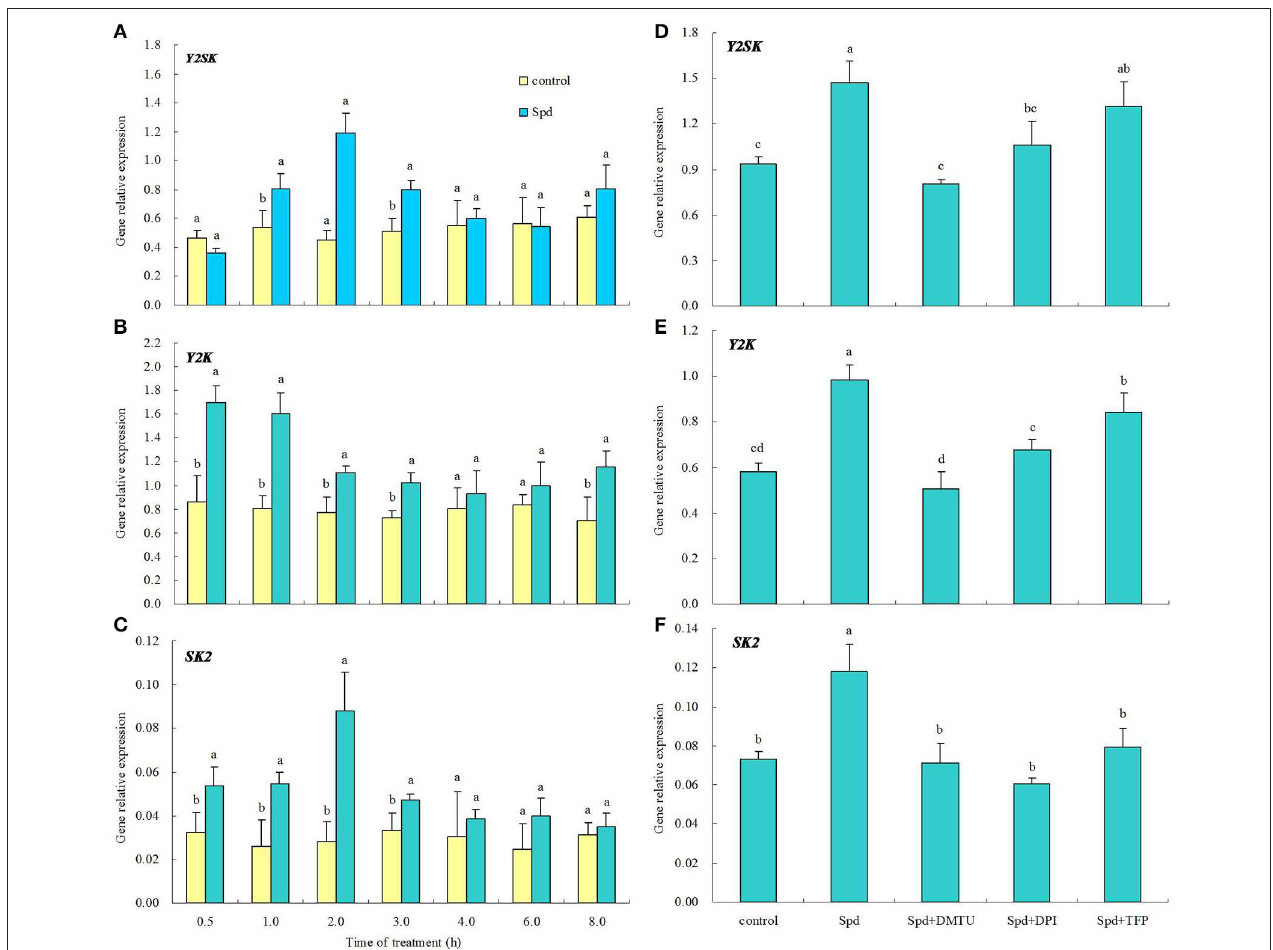
FIGURE 13 | Spd-induced dehydrins Y 2 SK , Y 2 K and SK 2 genes relative expression were dependent on hydrogen peroxide (H 2 O 2 ) and CDPK. The detached leaves of white clover were pre-treated with distilled water for 1h to eliminate wound stress and then treated for different times (A–C) or 2h (D–F) as follows: 1, distilled water (control); 2, 20 µ M Spd; 3, 20 µ M Spd + 5mM dimethylthiourea (DMTU); 4, 20 µ M Spd + 100 µ M Diphenyleneiodonium (DPI); 5, 20 µ M Spd + 30 µ M trifluoperazine (TFP). Means of four independent samples and standard errors are presented. The different letter above the columns between two treatments at a given time indicates significant difference at P < 0.05 (A–C) . The same letter above the columns indicates no significant difference at P < 0.05 (D–F)